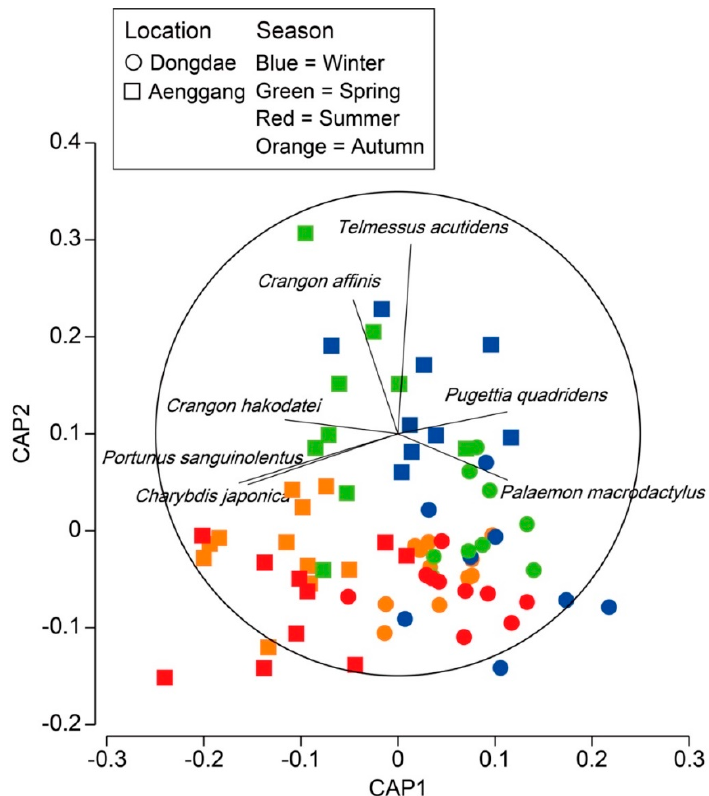
Figure 4. Ordination plots for canonical analysis of principal coordinates of decapod assemblage location–season interaction term.